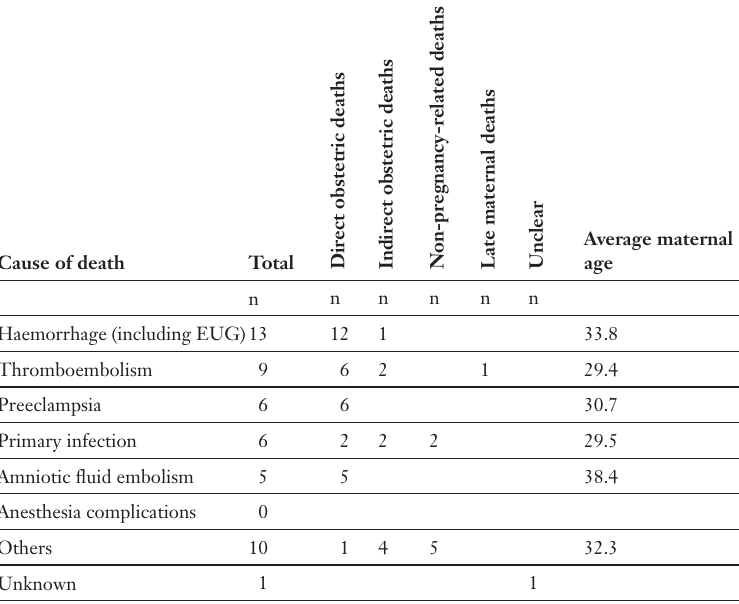
Causes of deaths and classification.